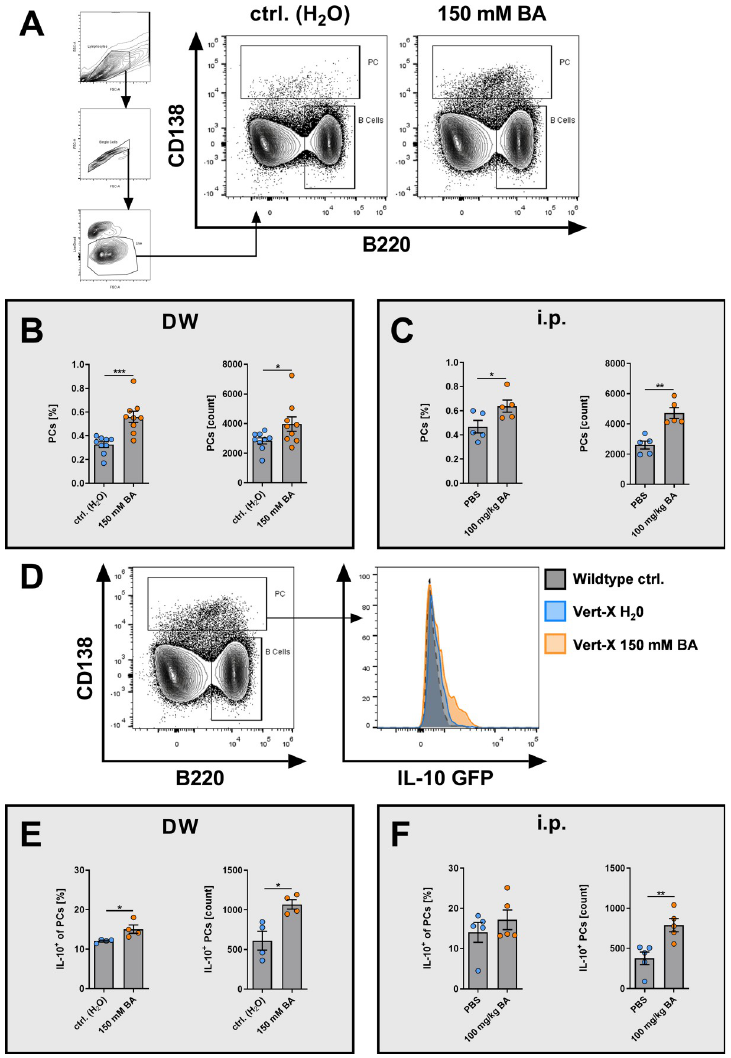
Fig 3. Butyrate promotes the differentiation of CD138 high PCs and IL-10 + CD138 high PCs in Ova-immunized mice. Wildtype or IL-10 reporter mice (IL-10 GFP or Vert-X) were treated for seven days with BA via drinking water or i.p. injection before i.p. immunization with Ova/CFA. 12 days after Ova/CFA treatment splenic cells were harvested and analyzed by flow cytometry. (A) Flow cytometric gating strategy and representative contour plots for CD138 high PCs in control and BA-treated mice. (B+C) CD138 high PC frequencies and cell counts for mice treated with either (B) drinking water (ctrl.) or BA (150 mM) (n = 9) or (C) daily i.p. injection of either PBS vehicle control or BA (100 mg/ kg) (n = 5). (D) Flow cytometric gating strategy and representative histogram plots for IL-10 + CD138 high PCs in BA- treated IL-10 reporter mice. (E, F) Frequencies and cell counts of IL-10 + cells among CD138 high PCs for mice treated with either (E) drinking water (ctrl.) or BA (150 mM) (n = 4) or (F) daily i.p. injection of either PBS vehicle control or BA (100 mg/kg) (n = 5). � p < 0.050, �� p < 0.010, ��� p < 0.001. injection: 44.5%) in BA-treated mice (p < 0.0001 for both treatments; Fig 4B–4D left panels ). These differences were reflected also by the median fluorescence intensities (MFI) of IgM in IL-10 - and IL-10 + CD138 high PCs (p < 0.0001 for both treatments; Fig 4C, 4D right panels ). Similarly, the frequency of IL-10 + PCs, as well as the IL-10 GFP MFI, were significantly higher among IgM + CD138 high PCs compared to IgM - CD138 high PCs in BA-treated mice (p < 0.0001 for both treatments; Fig 4E–4G ).